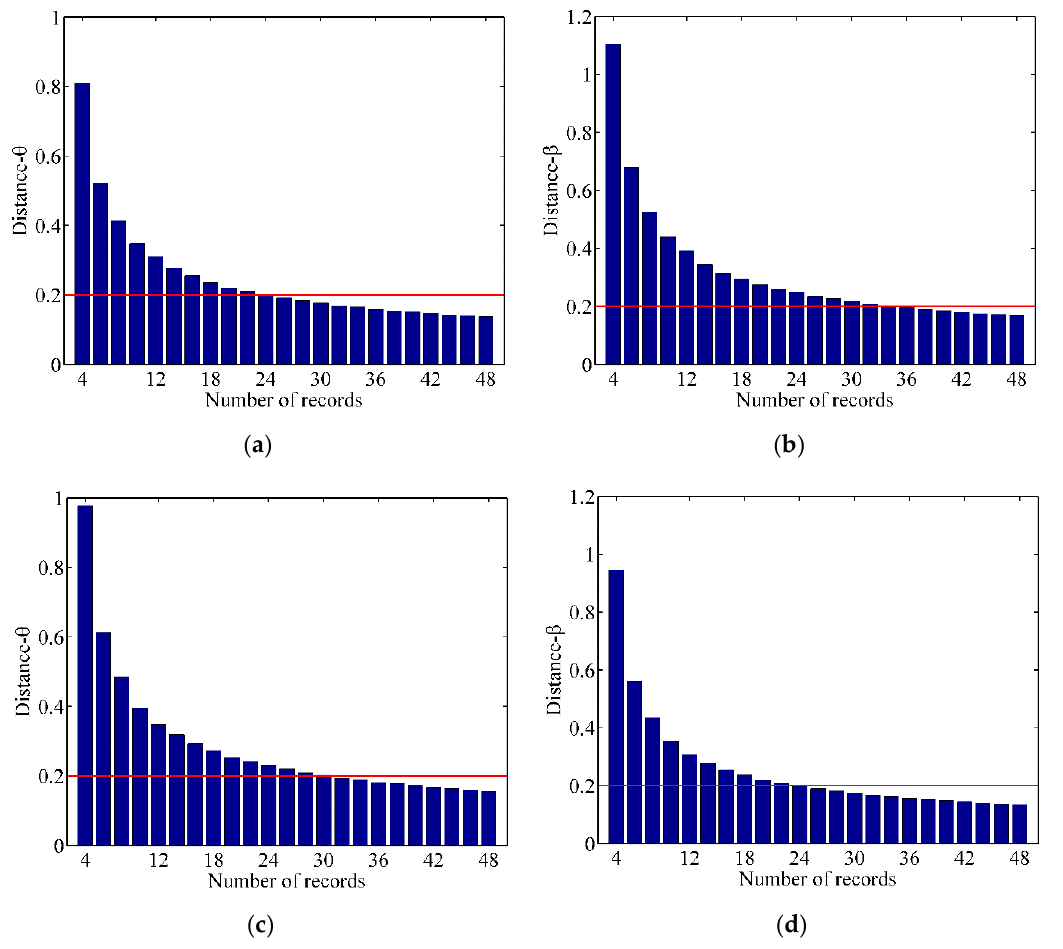
Figure 11. The scope of lower and upper 95% confidence interval for estimated θ and β with different number of records: ( a , b ) for parked condition, and ( c , d ) for normal operation condition.